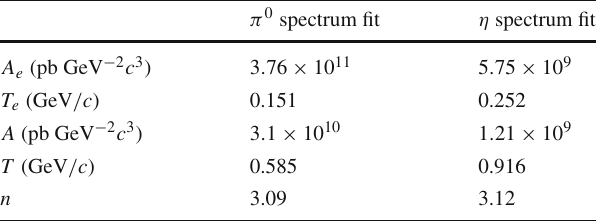
Table6 FitparametersoftheTCMfitstothereference π 0 and η spectra √ s = 5 . 02 in pp collisions at